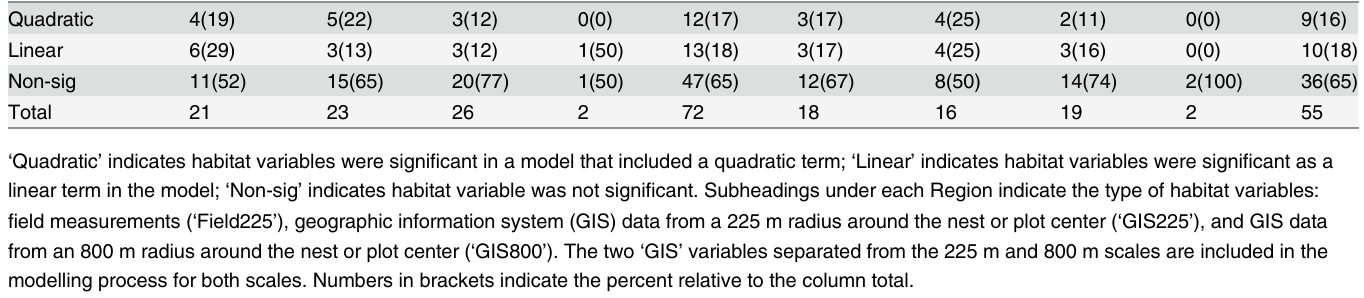
Table 1. Numbers of explanatory variables considered in generalized linear models for the probability of Williamson ’ s sapsucker nest occurrence in two regions of southern British Columbia. Variable type